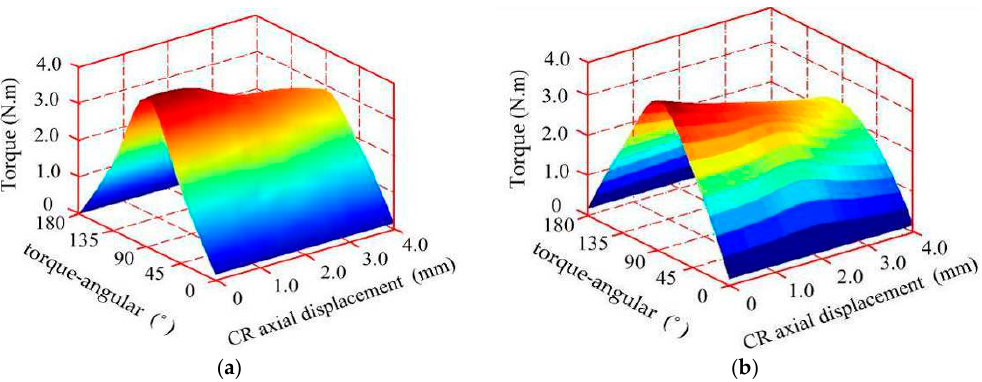
Figure 22. The torque-angular characteristics at 5 A of the CR-PMSM: ( a ) Calculation results of torque, ( b ) Experimental results of torque.